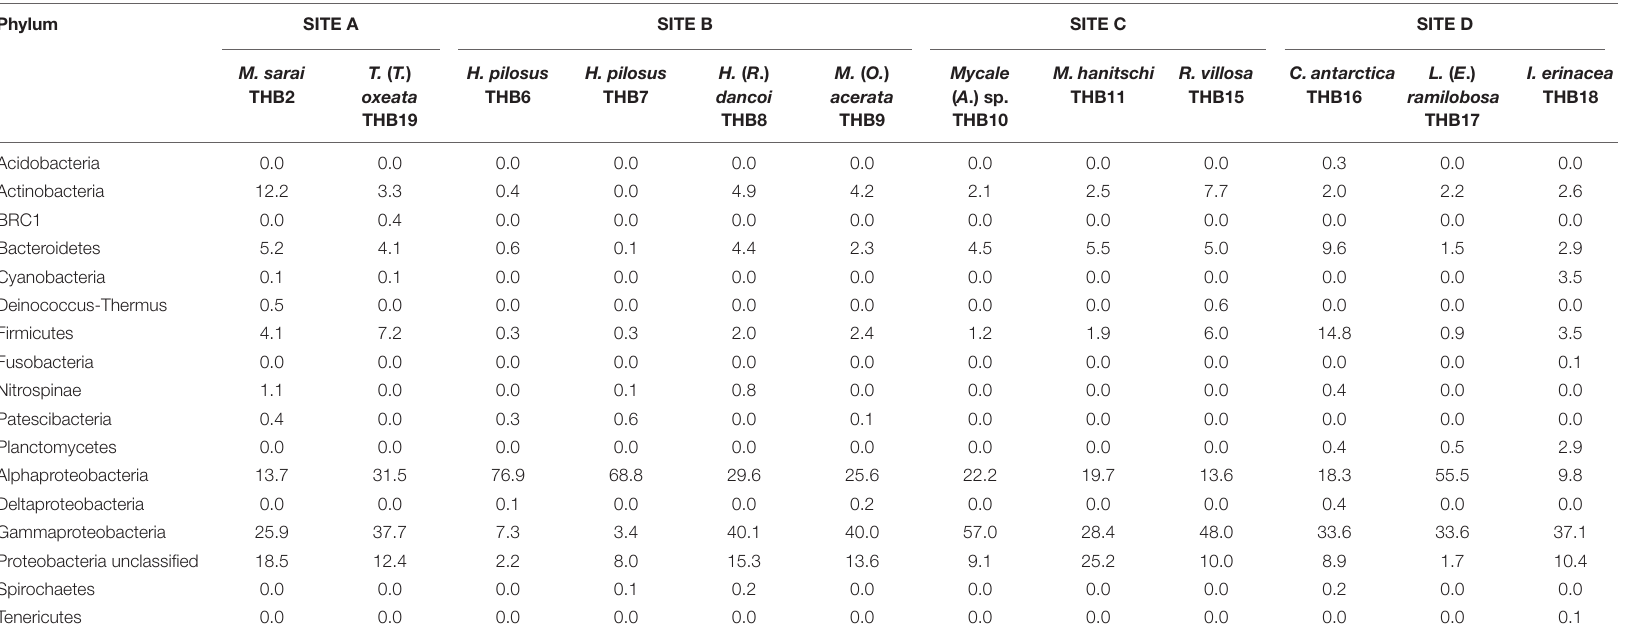
TABLE 2 | Relative abundance values (%) of bacterial phyla retrieved in sponge samples.